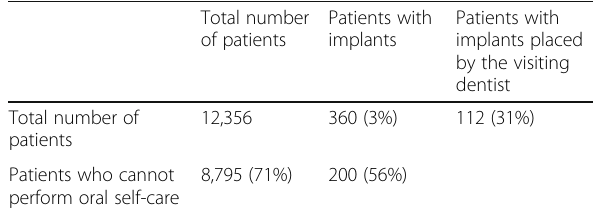
Table 3 Have you been consulted by your implant patients or their families about oral health management when the patients were admitted to the hospital or became bedridden?